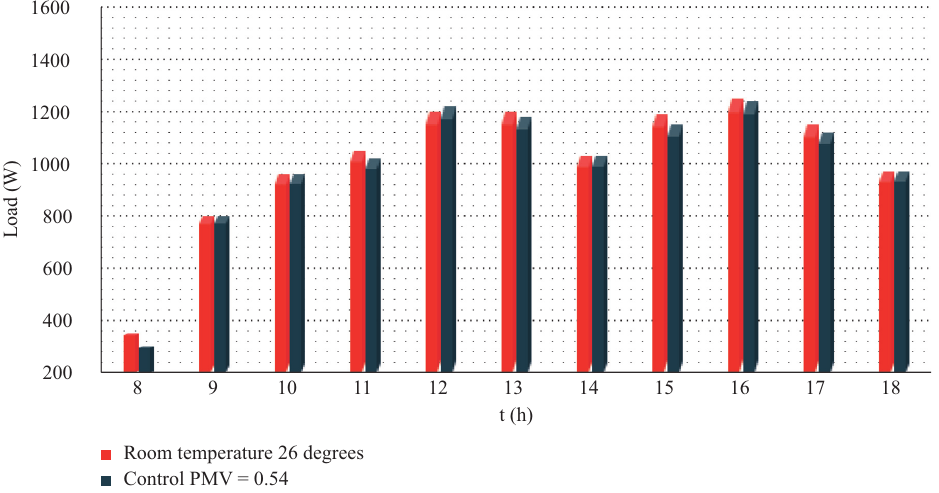
Figure 6: Energy consumption change chart under different control